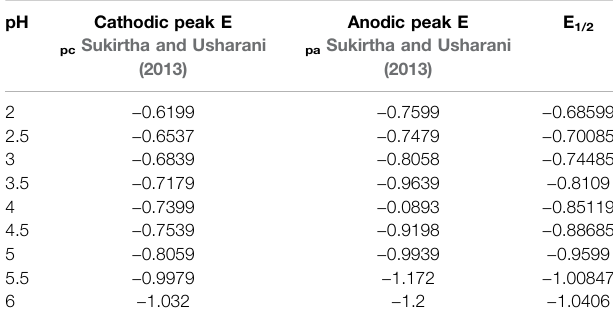
TABLE 1 | pH study of fabricated P 2 W 18 POM/AgNPs/GCE. pH Cathodic peak